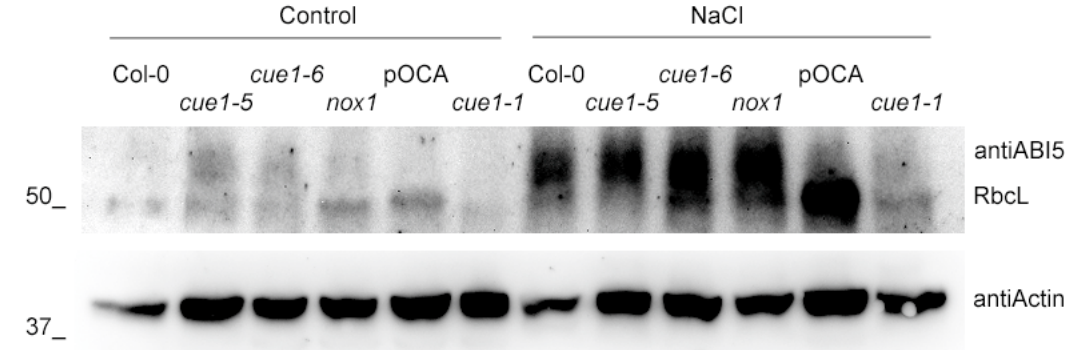
Figure 3. Germination inhibitor ABI5 is stabilized in cue1-5 and in the presence of salt stress. Western blot analysis of ABI5 accumulation in the di ff erent cue1 lines grown on MS with and without 100 mM NaCl for 4 das. Actin levels are shown as loading